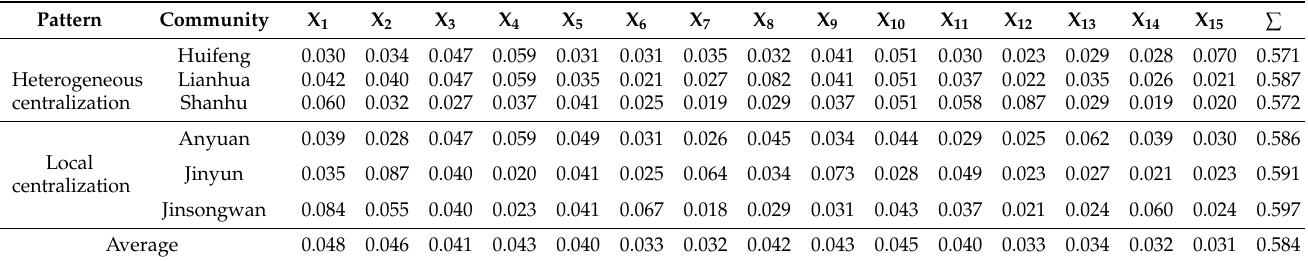
Table 6. Grey weighted relational grade of public space satisfaction of new centralized communities.